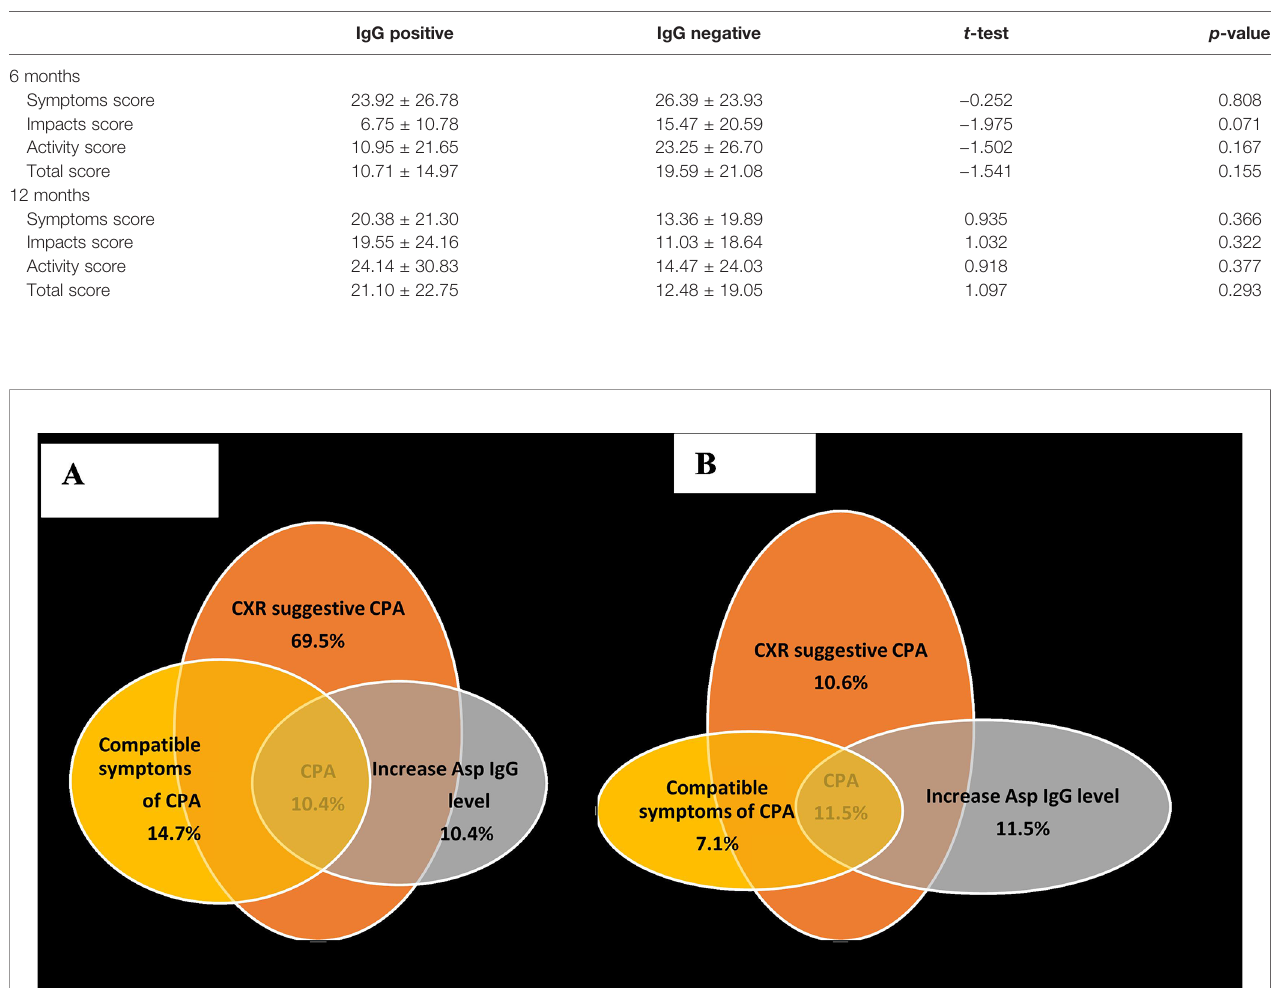
TABLE 6 | SGRQ in those with Aspergillus IgG-positive versus Aspergillus IgG-negative